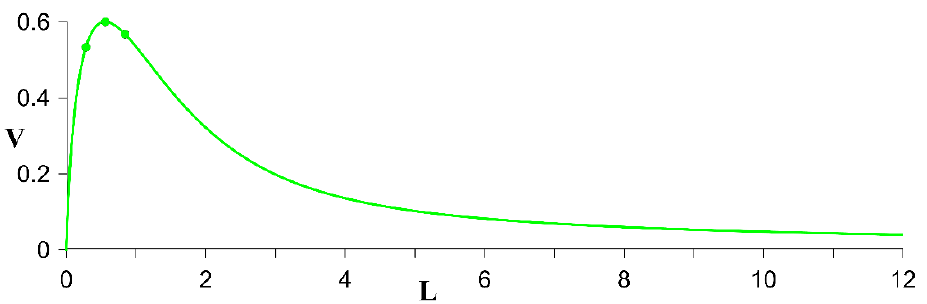
Figure 1. The translational velocity 𝑉 vs. 𝐿 of the vortex structure composed of the point vortices (4) in the upper and middle layers. The coordinates of the markers correspond to the parameters of the numerical experiments shown in Figure 2a.